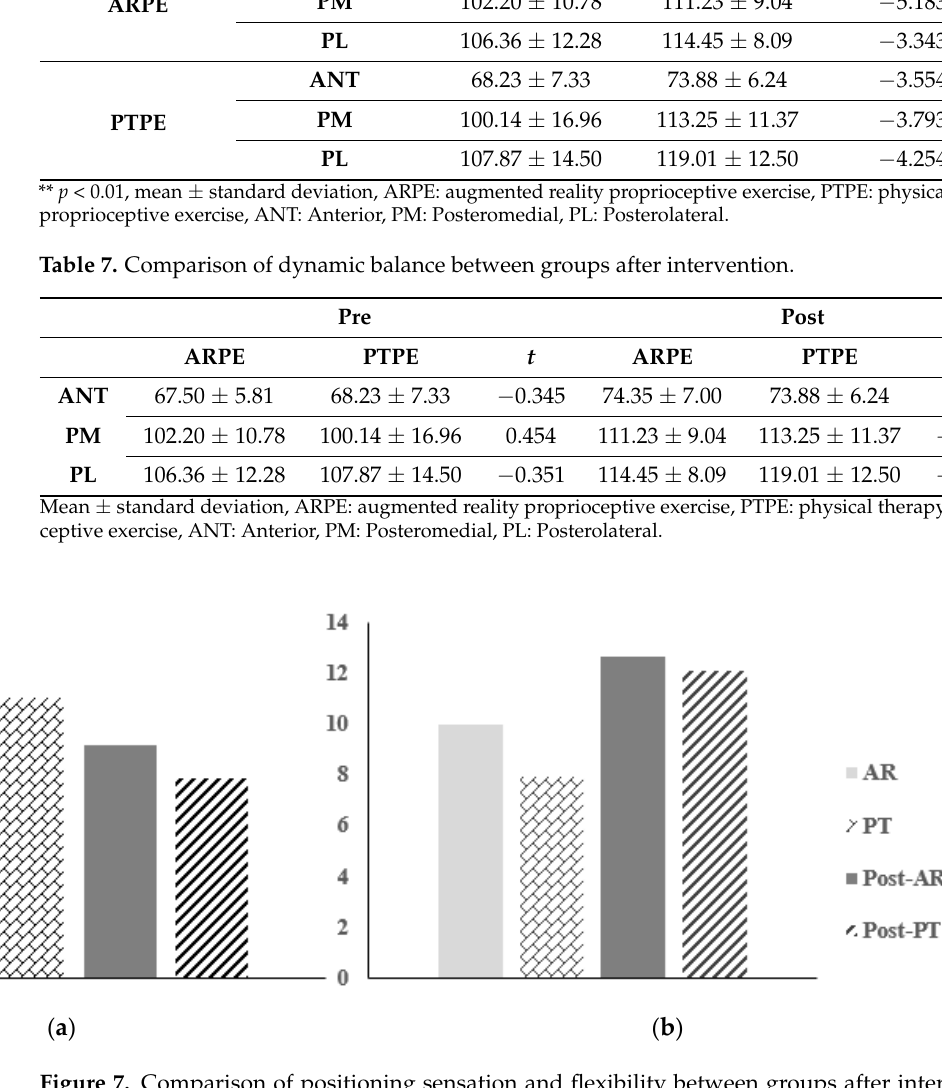
Table 6. Comparison of dynamic balance within a group after intervention. Pre Post Table 8. Comparison of positioning sensation within and between groups before and after interven- tion application.